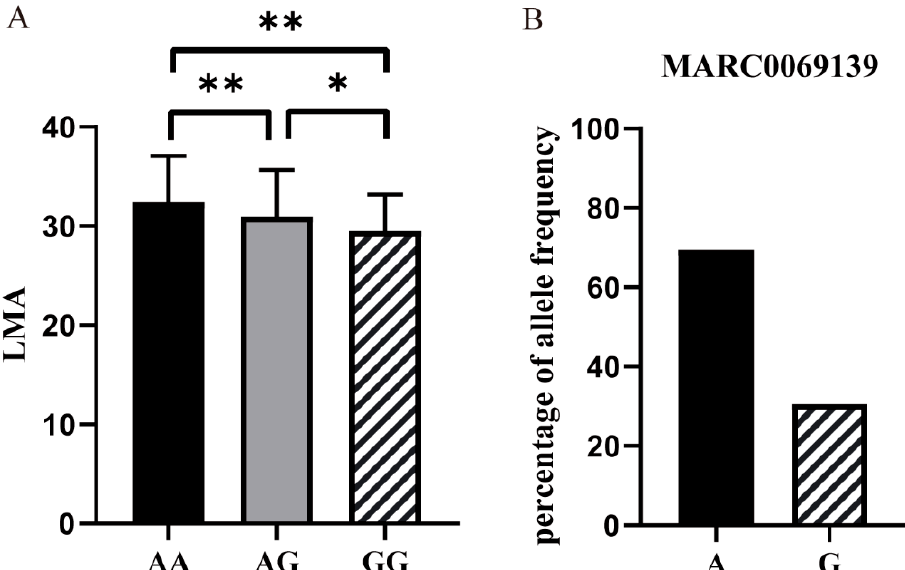
Figure 2. Identification of MARC0069139 using GWAS of loin muscle area. ( A ) The difference analysis among three genotypes of MARC0069139 in Beijing Black pigs. * p < 0.05, ** p < 0.01. ( B ) Allele frequencies of MARC0069139 in Beijing Black pigs.